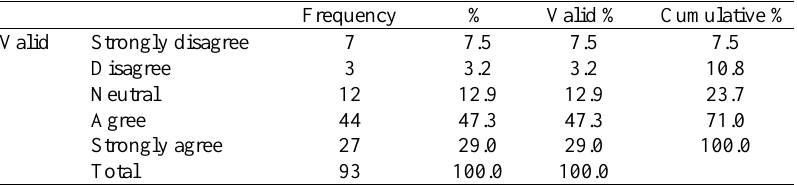
Table 2 Students who used the online space to conduct online chats As students we helped each other by way of interacting with one another in the chat